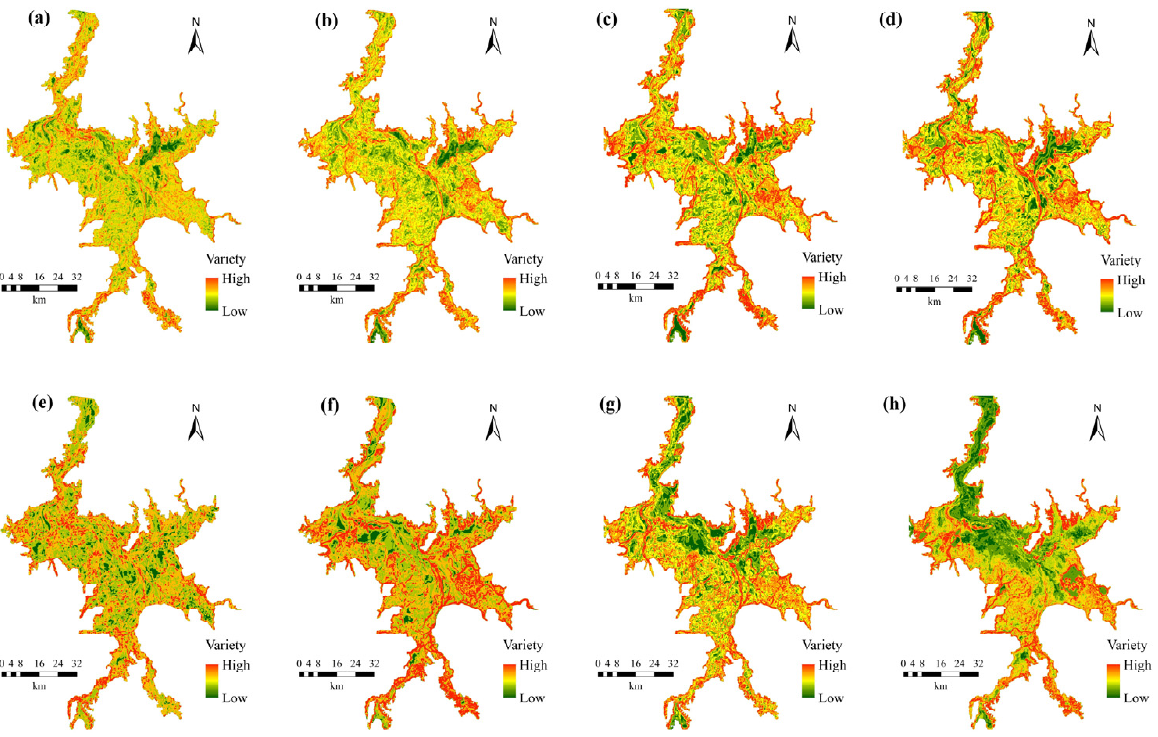
Figure 5. Varieties of crane habitats within various water level intervals: ( a ) 5–6 m; ( b ) 6–7 m; ( c ) 7–8 m; ( d ) 8–9 m; ( e ) 9–10 m; ( f ) 10–11 m; ( g ) 11–12 m; ( h ) 12–16 m.